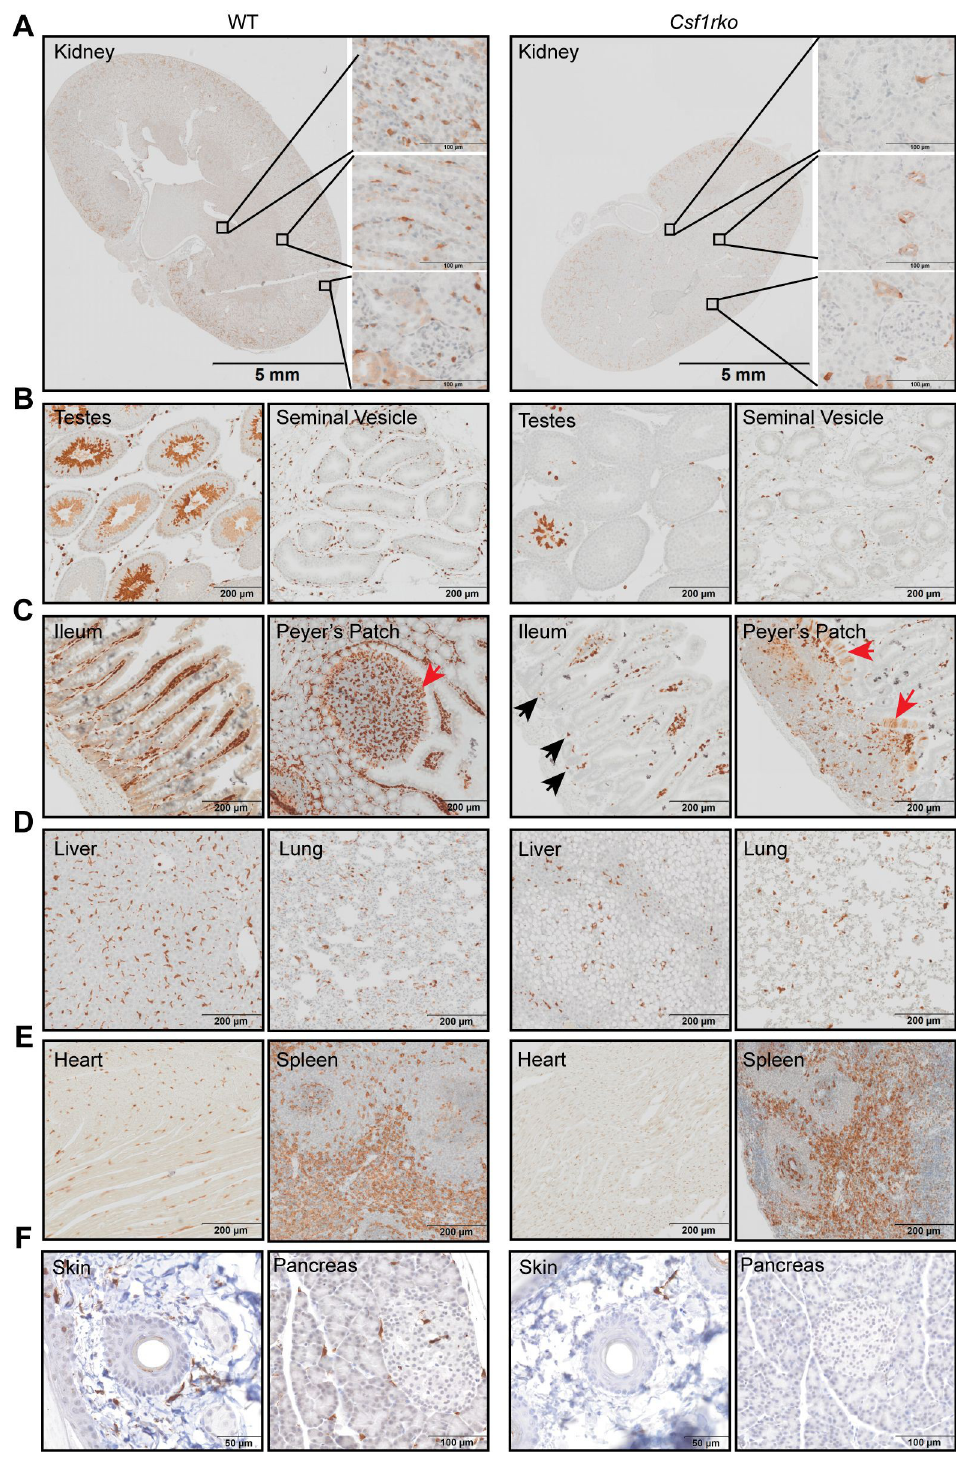
Fig 9. Immunolocalization of IBA1 + cells in WT and Csf1rko rat organs at 7 wks. IBA1 was detected in rat tissues by immunohistochemistry as described in Materials and Methods. Brown stain (diaminobenzidine) is a positive signal; sections were counterstained with haematoxylin (blue). Representative images show localisation of IBA1 in (A) kidney, (B) testes and seminal vesicles, (C) small intestine including Peyer’s patches, (D) lung and heart, (E) liver and spleen, (F) Tail skin and (G) pancreas of WT and Csf1rko rats. M cells in small intestine are indicated by red arrows in (C). Black arrowheads highlight IBA1 + cells in the base of the crypts in (C). https://doi.org/10.1371/journal.pgen.1009605.g009 PLOS Genetics | https://doi.org/10.1371/journal.pgen.1009605 June 3,